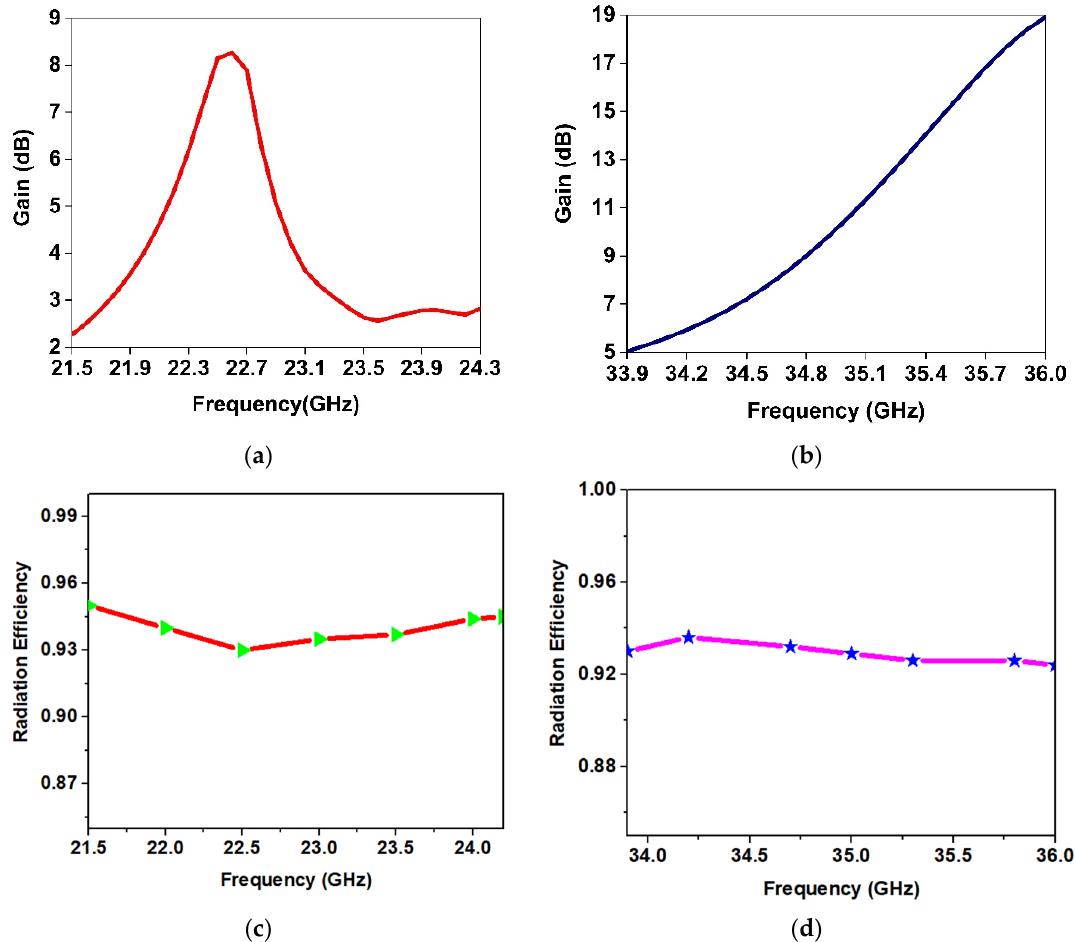
Figure 16. Variation of gain vs. frequency for the bandwidth of operation for a resonant frequency of ( a ) 22.7 and ( b ) 34.9 GHz, and variation of radiation efficiency vs. frequency for the bandwidth of operation for a resonant frequency of ( c ) 22.7 and ( d ) 34.9 GHz.